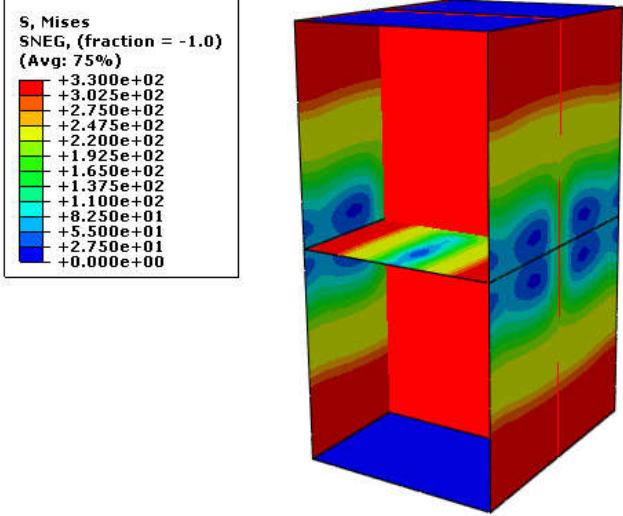
Figure 21. The stresses formed in sample BT150, 8 mm (kN/mm 2 ).